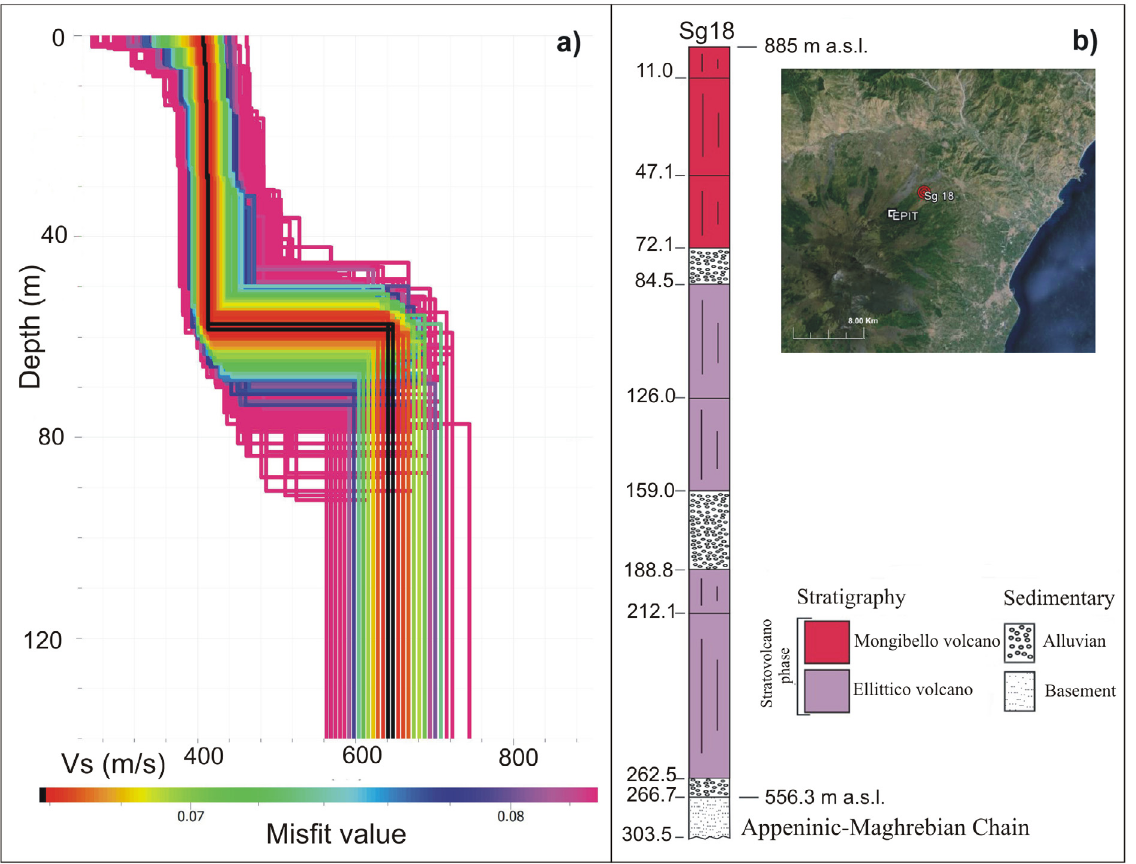
Figure 7. (a) 1D velocity profiles of shear waves obtained from the inversion of the dispersion curves. The velocity value corresponds to the minimum misfit of about 0.06 (black line). (b) Stratigraphy of the area, as obtained from borehole Sg18 (from Branca and Ferrara [2013]), located near Pozzo Pitarrone